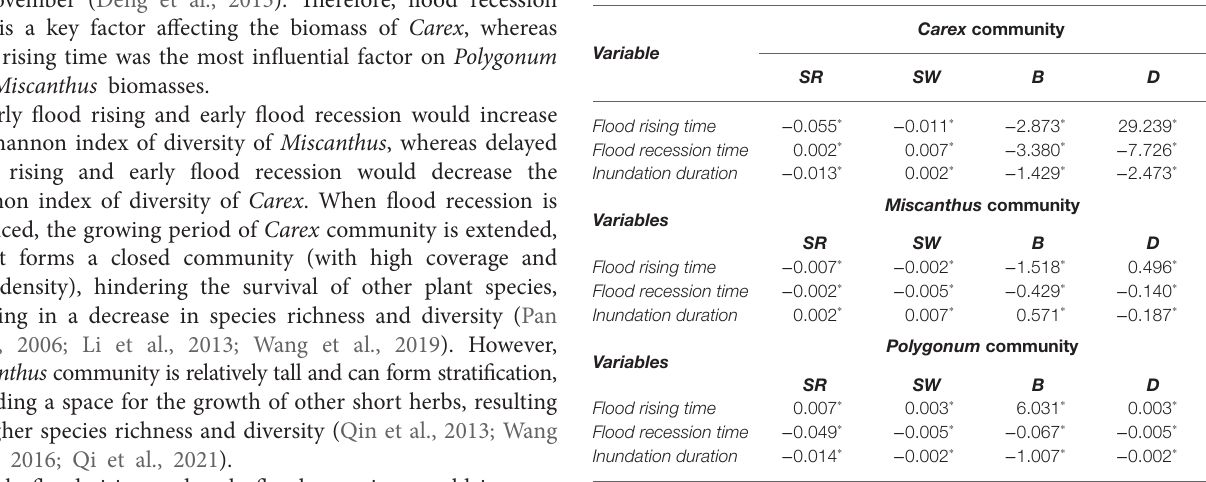
TABLE 3 | Summary of partial least square analysis of the effect of hydrological regimes on C. brevicuspis , M. sacchariflorus, and P. hydropiper community traits (species richness, density, biomass, and Shannon index of